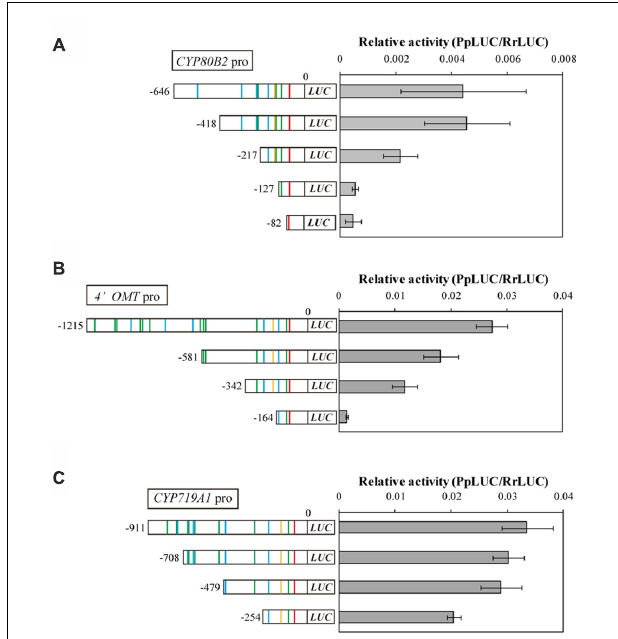
FIGURE 3 | The relative promoter activity of truncated CYP80B2 (A), 4 (cid:48) OMT (B), and CYP719A1 (C) constructs. Reporter plasmid vectors consisted of deleted promoter regions upstream of the LUC gene. Vectors were introduced into C. japonica protoplasts and relative LUC activities were measured by a dual-LUC reporter assay. The values are the averages of three biological transfections. The data are represented as the mean ± SD.